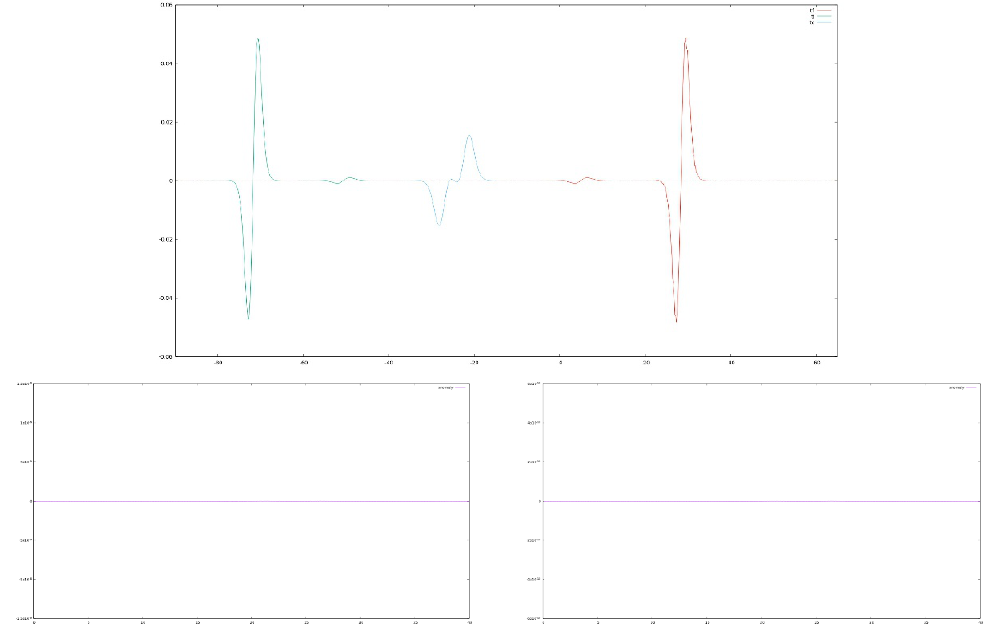
Figure 6 . Top (cid:12)gure shows the anomaly density of (cid:11) 3 in (4.24); i.e. the function ( w x v t u t ) plotted in x -coordinate for three successive times, t i = before collision (green), t c = collision (blue) and t f = after collision (red), for the 2-soliton of (cid:12)gure 2. Bottom (cid:12)gures show the plots of the anomaly (cid:11) 3 vs. t and the t -integrated anomaly R t (cid:15) q q ). The (cid:12)gure 7 presents the behaviour of h 2 xx tt